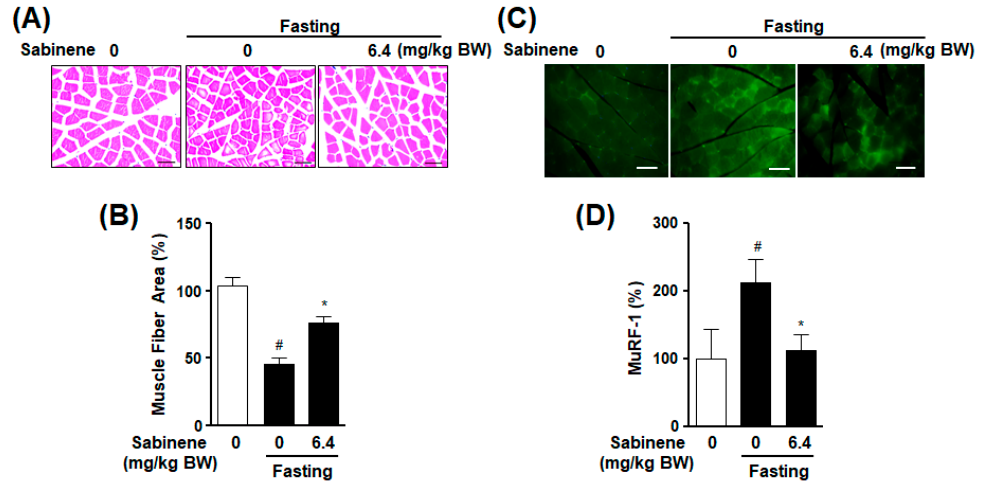
Figure 6. Effect of sabinene administration on fasting-induced gastrocnemius muscle atrophy in rats. Rats were orally treated with scoparone (6.4 mg kg/body weight (BW)) once every day for two days after fasting. Cross sections of gastrocnemius muscles isolated from each animal were stained with H and E or anti-MuRF-1 antibody. Muscle fiber size (area) and MuRF-1 expression were analyzed as described in Methods. ( A ) Representative image showing muscle fiber stained with Hematoxylin and Eosin (H and E). ( B ) Statistical graph obtained from panel ( A ). Muscle fiber area in gastrocnemius of non-fasted rats was considered as 100% ( n = 10). Scale bar: 100 µ m. * p < 0.05 vs. the fasted group in the absence of sabinene. # p < 0.05 vs. the non-fasted group. ( C ) Representative images showing MuRF-1 expression levels in muscles. ( D ) Statistical graph obtained from panel ( C ). MuRF-1 positive responses are expressed in light green color. Expression in non-fasted rat muscle was considered as 100% ( n = 6). Scale bar: 100 µ m. * p < 0.05 vs. the fasted group in the absence of sabinene. # p < 0.05 vs. the non-fasted group. BW: Body weight.